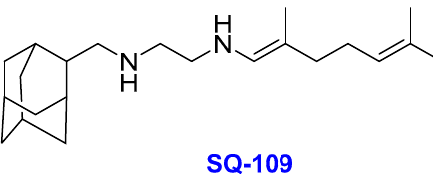
Figure 5. The chemical structure of SQ-109.